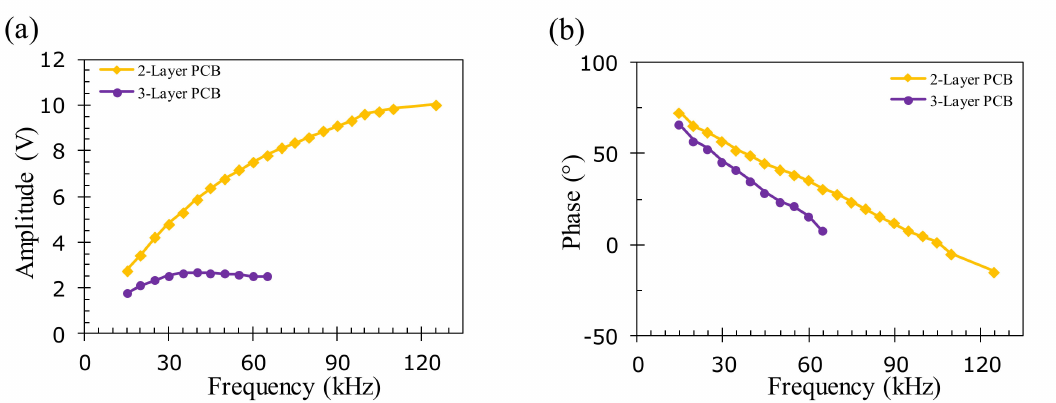
Figure 15. The amplitude and phase response of the EC signals on a crack with a 0.8 mm width and 15 mm length located respectively on the first and second layers of the two- and three-layer PCB samples with increasing frequencies. ( a ) Peak amplitude and ( b ) corresponding phase.